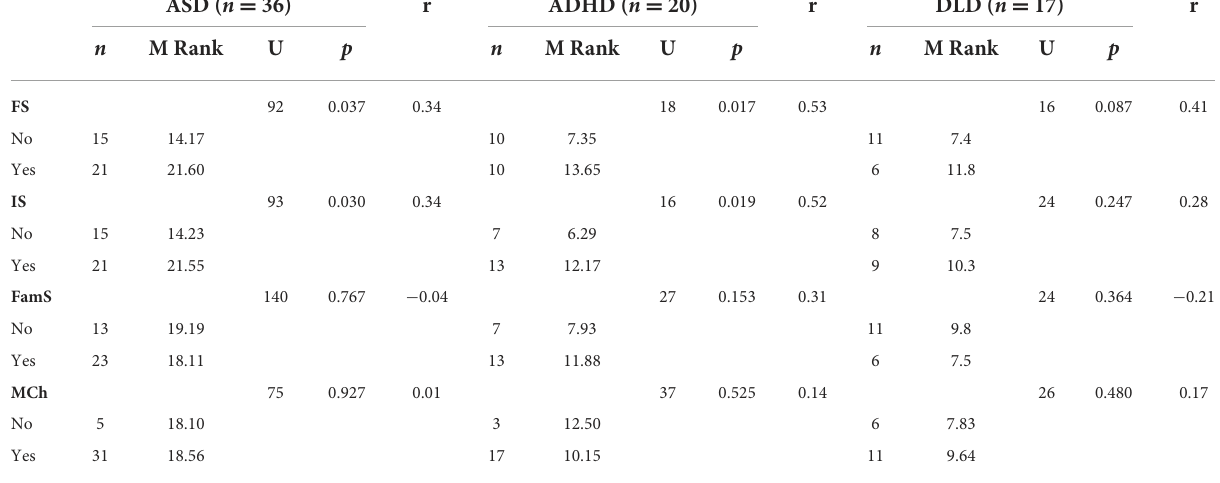
TABLE 2 Relationship between the different types of social supports and the level of resilience of parents in the different clinical groups. ASD ( n =